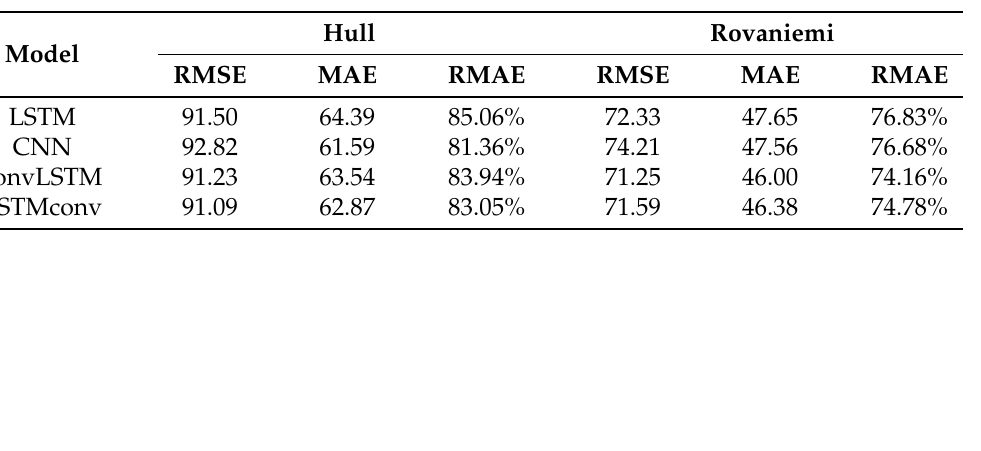
Table A1. Performance results of the different NN models for the cites Hull and